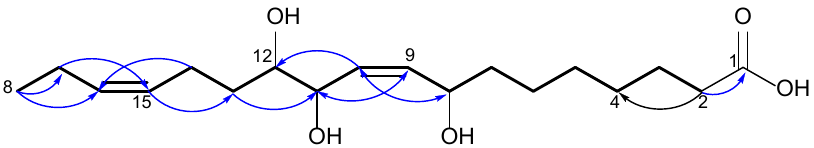
C) correlations of compound 4 . →